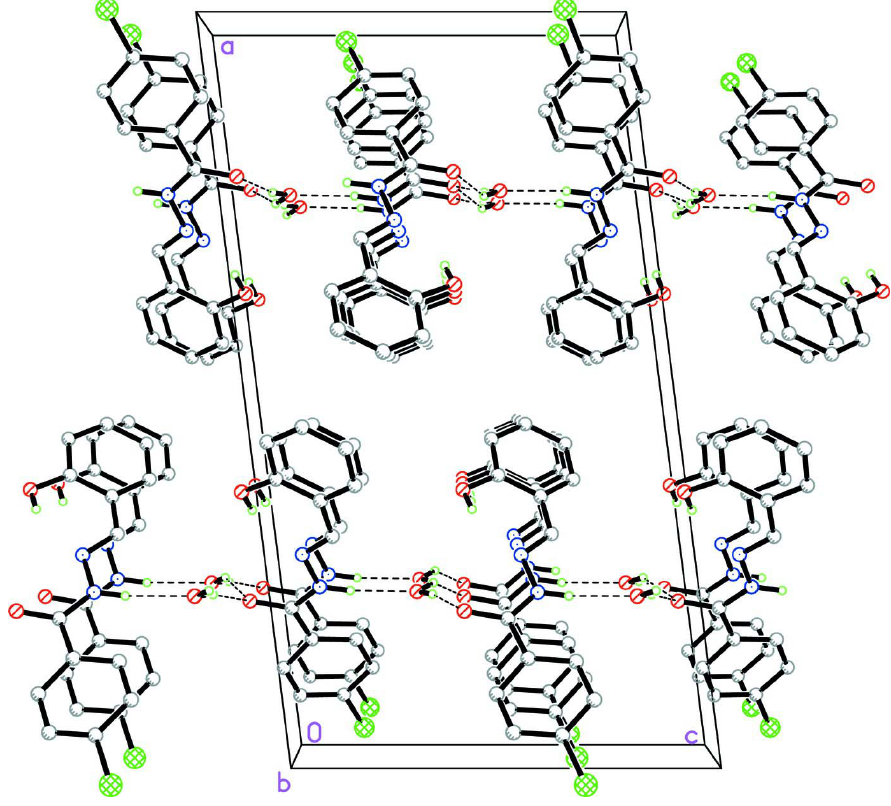
Figure 2 The crystal packing of the title compound, viewed along the b axis. Hydrogen bonds are shown as dashed